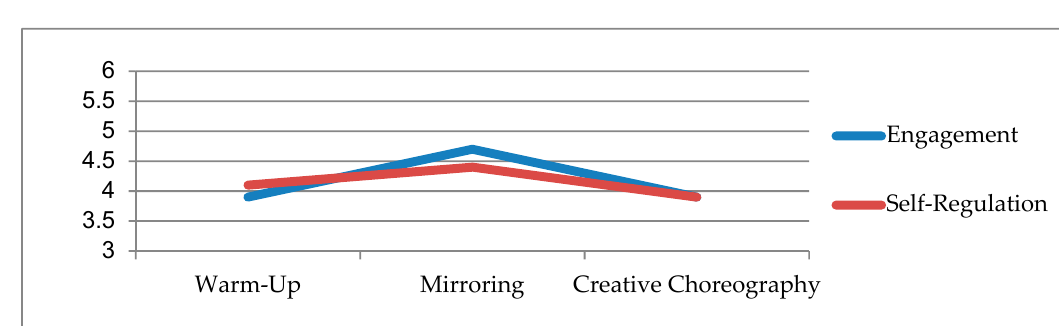
Figure 1. Participant engagement and self-regulation during sessions.